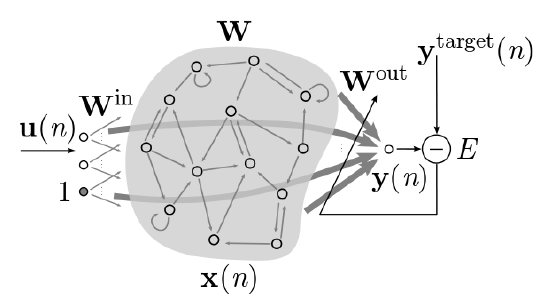
Figure 1. The Echo State Network architecture